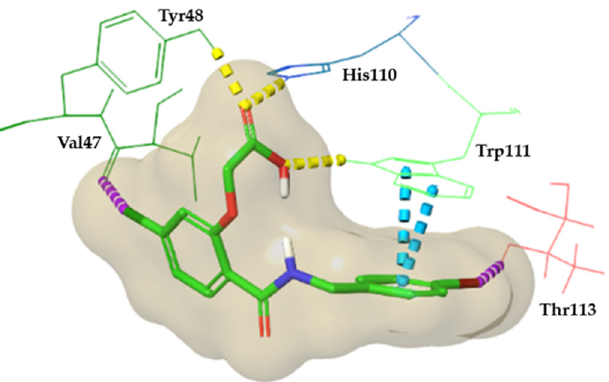
Figure 1. The binding mode of the cocrystallized ligand ({2-[(4-bromobenzyl)carbamoyl]-5- chlorophenoxy}acetic acid-W8X) at the active site of AR (PDB ID: 4LAU). Halogen bonds, hydrogen bonds, and pi–pi interactions are depicted in purple, yellow, and blue dashed lines,